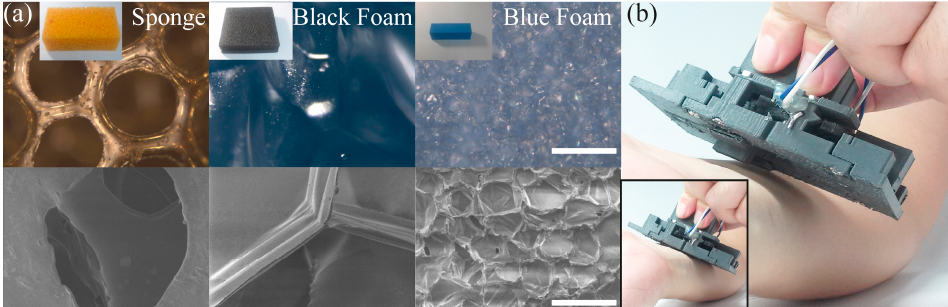
Figure 7. Demonstration of stiffness measurement. ( a ) Various objects for stiffness measurements. Top row: optical images taken at 100 times magnitude. The scale bar represents 200 μ m. Insets: pictures of the objects. The dimension of sponge, black foam, and blue foam were 9 cm (length) × 5 cm (width) × 2.5 cm (thickness), 12 cm × 10 cm × 2 cm, and 8 cm × 3 cm × 3 cm, respectively. Bottom row: scanning electron microscope images of the same materials in the top row taken at 200 times magnitude. The scale bar represents 100 μ m. ( b ) A picture showing a measurement being taken on the forearm skin. Inset shows the moment when the t-modules were activated.